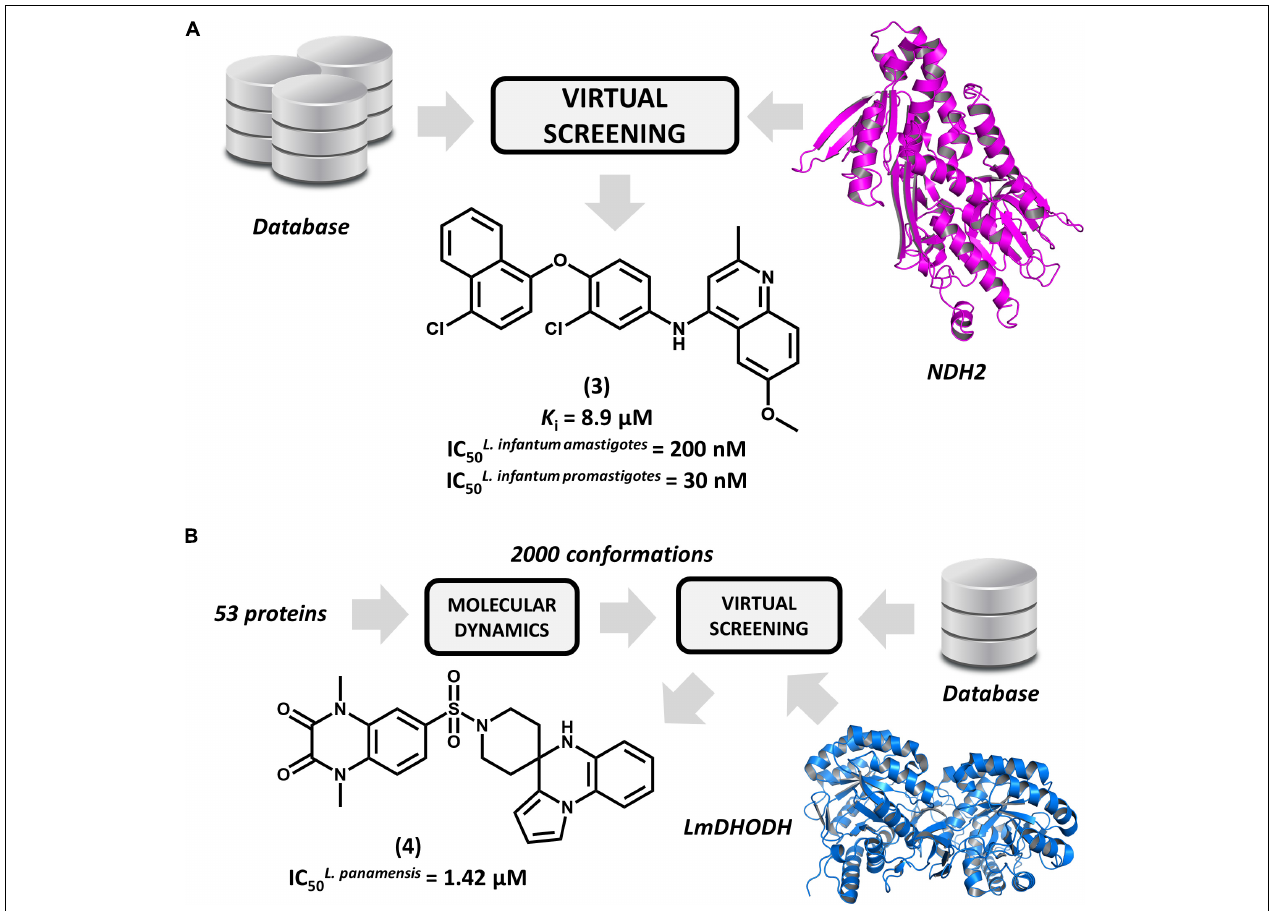
FIGURE 3 | Structure-based drug design (SBDD) strategies using virtual screening and molecular dynamics. (A) An SBDD workflow targeting type 2 NADH dehydrogenase (NDH2) resulting in the identification of compound 3 , a remarkably potent antileishmanial agent. (B) An SBDD strategy targeting diverse Leishmania proteins that led to the discovery of 4 , a novel compound having promising antileishmanial